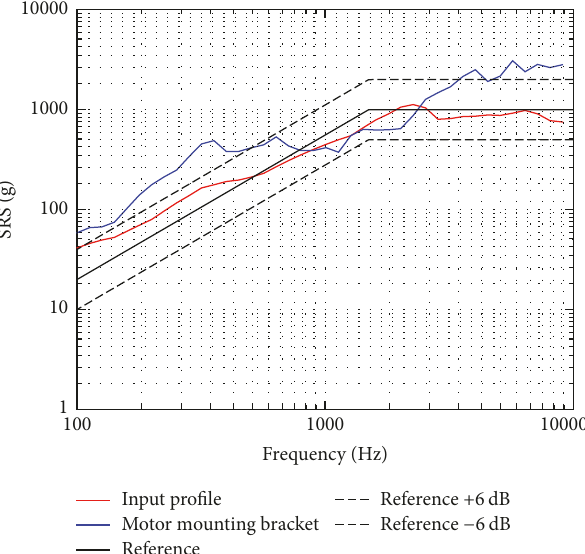
Figure 10: Example of the sine burst test result.